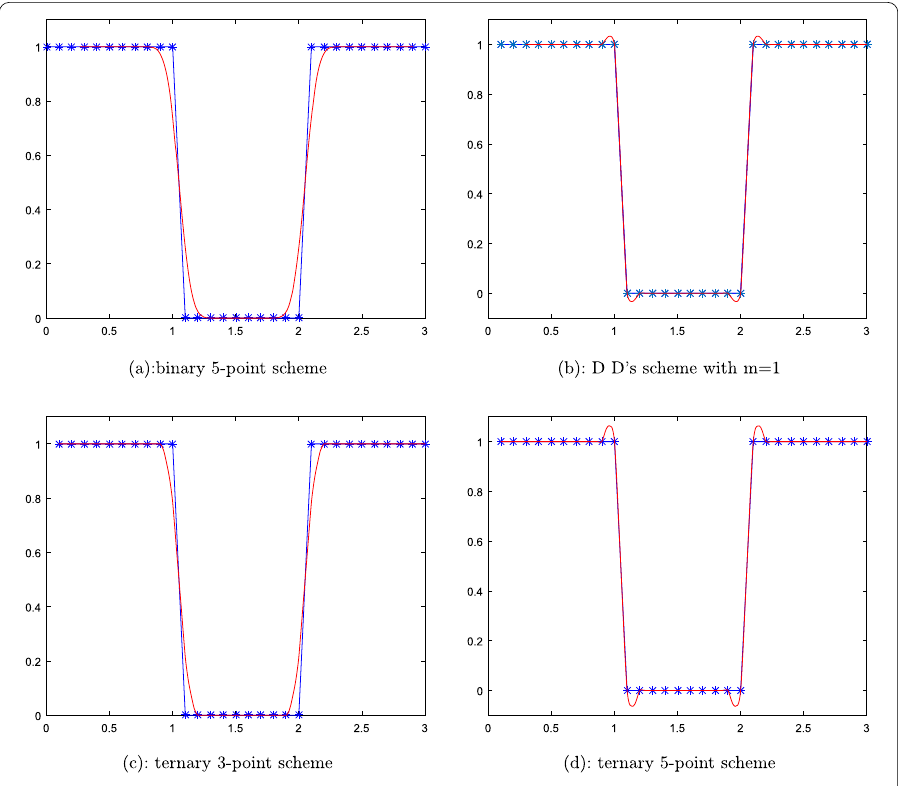
Figure 1 The limit functions of subdivision schemes. The blue ∗ denotes the original sampling of function (4.1), and the red solid line denotes the limit